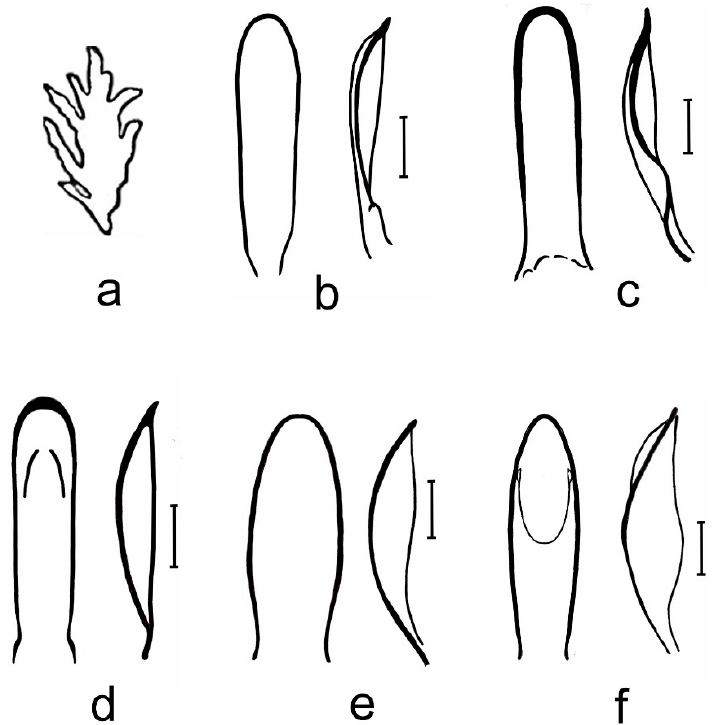
Figure 4. ( a ). Multifurcate scale; b – f . male genitalia, dorsal and lateral views; ( b ). Philenis fuscofemorata ; ( c ) P. costaricensis ; ( d ) P. laselvaensis ; ( e ) P. brunnea ; ( f ) P. chiriquiensis ; scale bars = 0.2 mm.